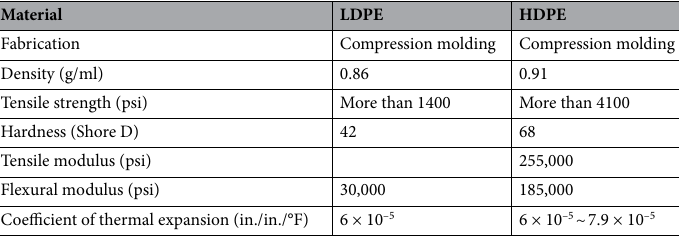
Table 1. Physical and mechanical properties of LDPE and HDPE